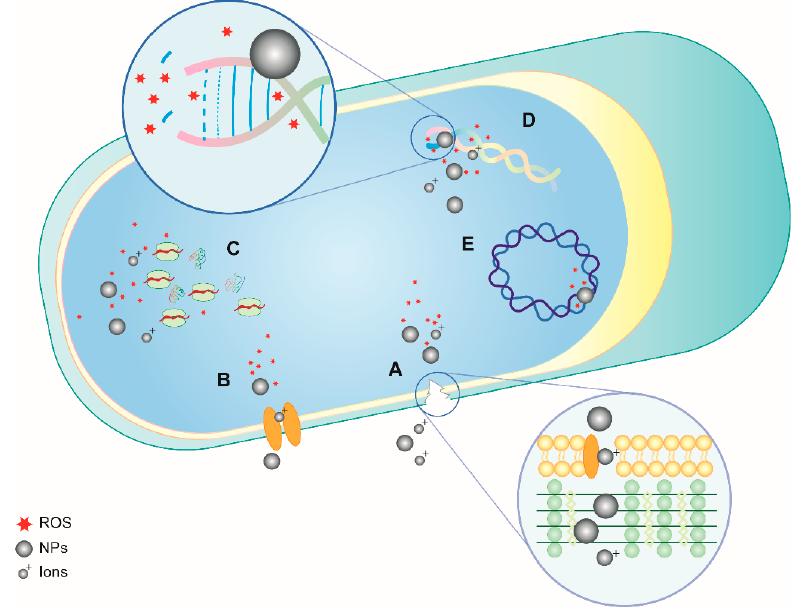
Figure 1. Schematic representation of the reaction of bacteria following the exposure to reactive oxygen species generated by NPs and ions. The illustration shows ( A ) cell wall disruption and NP and ion penetration, ( B ) the interruption of electron transport, ( C ) damages to the ribosome affecting the protein synthesis, ( D ) intercalation between DNA bases with consequent irreparable damages, and ( E ) the negative interaction with plasmid DNA.